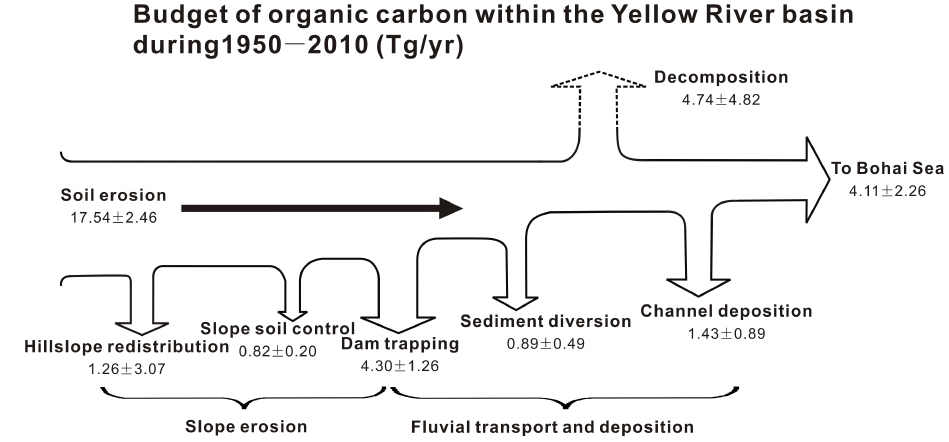
Fig. 5. Redistribution of the eroded organic carbon in the Yellow River basin during the period 1950–2010. The line widths of the arrows are approximately proportional to the average carbon